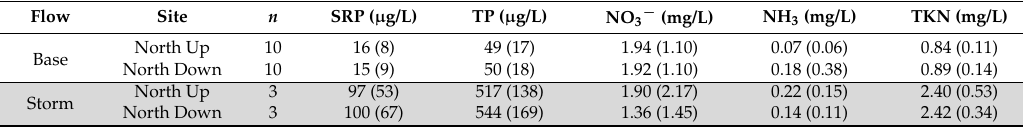
Figure 7. SRP and TP concentrations measured at Haworth wetland for 2017 ( A , C ) and total project history ( B , D ). Colored data lines in (A,C) magnify the 2017 baseflow data shown in (B,D). Symbols represent storm events. Vertical dotted lines represent approximate completion date of wetland restoration construction. Table 8. Mean (1 SD) values of nutrient concentrations at the Haworth restoration site for the 2017 sampling year. Storm flow data shown in gray shade.